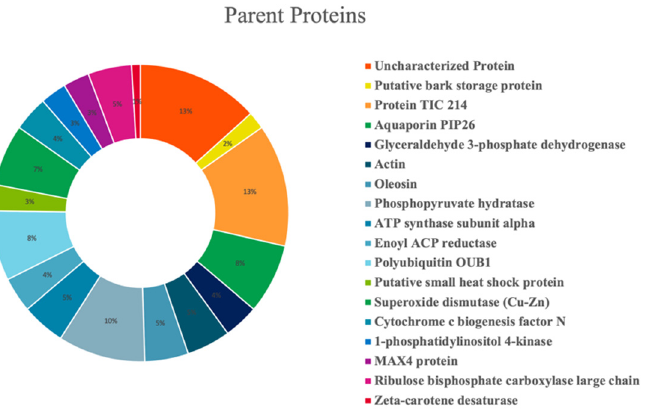
Figure 5. Percent distribution of identified peptides according to their parent proteins.